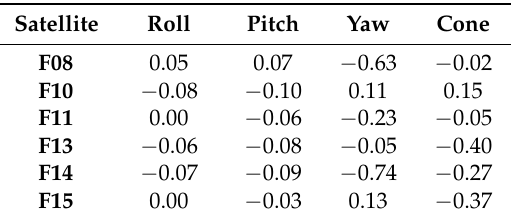
Figure 3. Observed minus simulated Tb as a function of scan position for the F10 19v channel averaged over 1992 and 1996. The top panel shows the original cross-scan bias in blue, with the dots indicating the position values used to derive the roll and pitch offsets. The resulting fit to roll and pitch is shown by the solid black line with the mean roll and pitch values given in the lower left. The bottom panel shows the cold ( Blue ) and warm ( Red ) scene cross-track bias after accounting for the roll and pitch offsets. The cross-track bias correction is derived based on these curves using the equation from [15]. Table 2. Roll, pitch, yaw and half-cone angle offsets in degrees derived from the cross-scan bias and geolocation analysis for each of the SSM/I